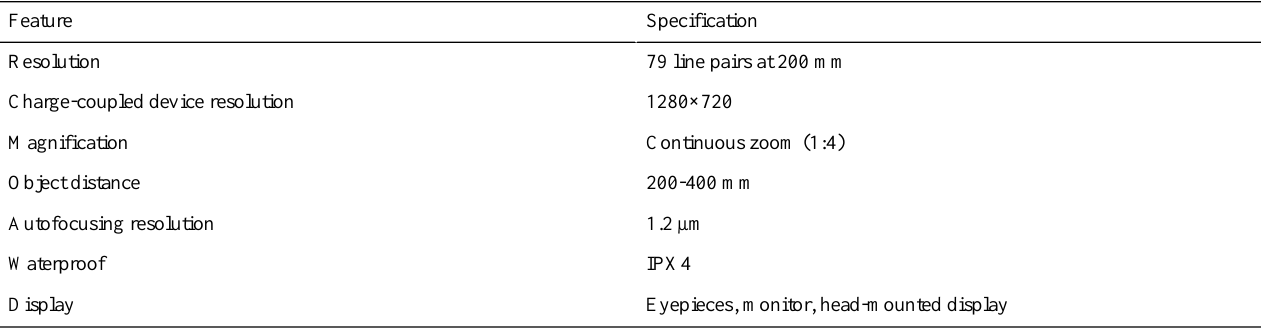
Table 1. Specification of the optical system of the proposed stereoscopic